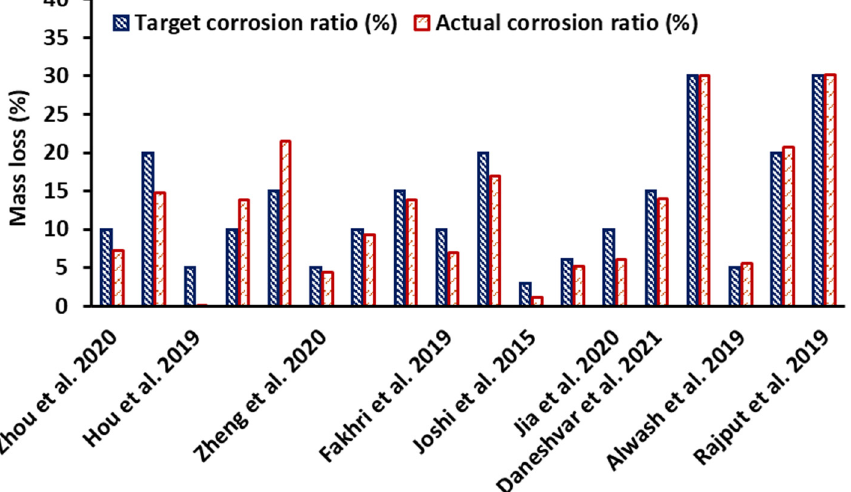
Figure 12. Comparison of the theoretical and actual corrosion ratios [16,42,48,100,110,111,114,115,117].